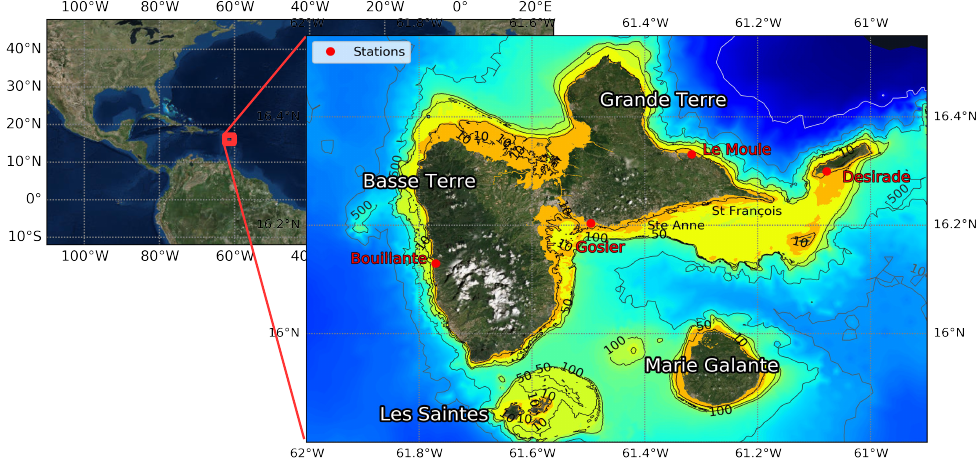
Figure 1. Guadeloupe archipelago location and bathymetry. Virtual gauges are indicated by red